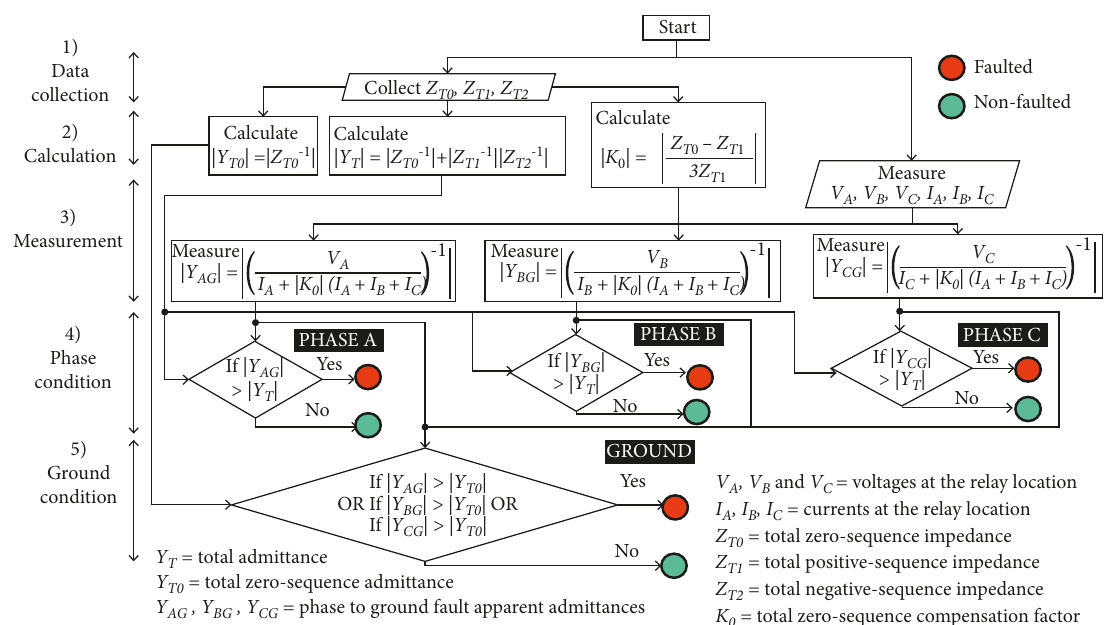
Figure 1: PGFA admittance with phase/ground boundaries to detect the types of electrical